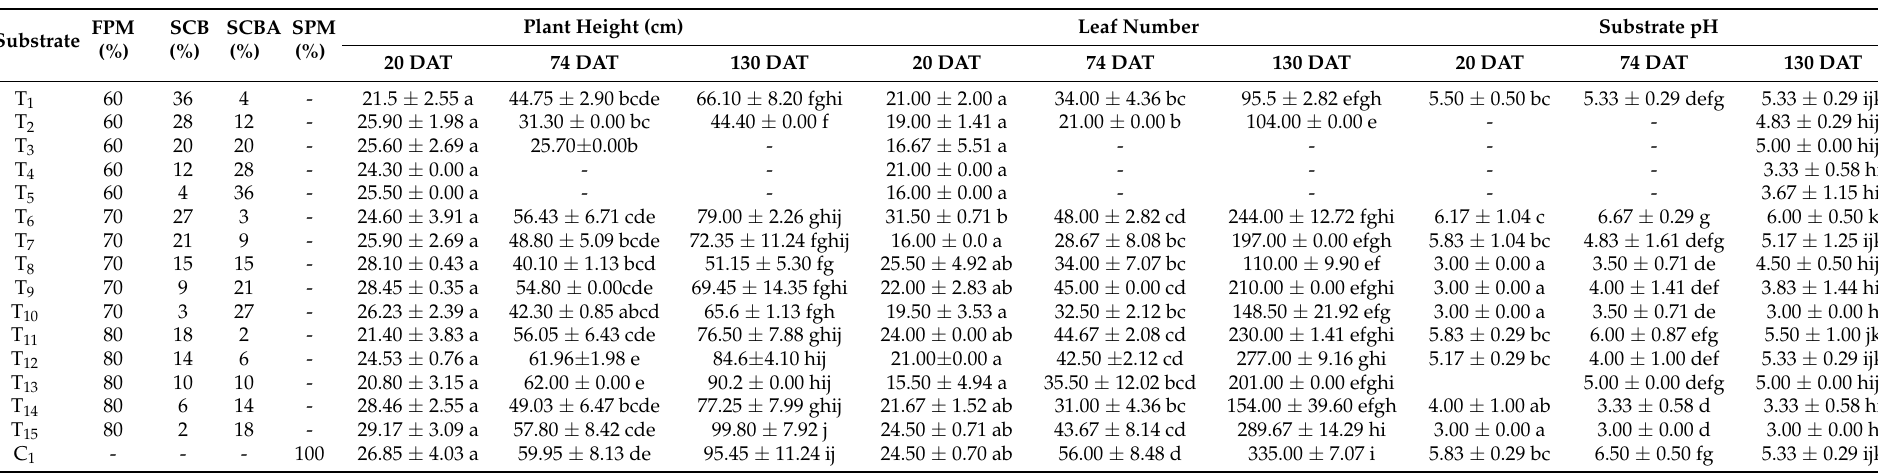
Table 3. Compositions of the proposed substrates and effect of the substrate composition on the plant height, number of leaves and substrate pH, after 20, 74, and 130 days after transplanting (DAT). Different letters after means indicate significant differences at p ≤ 0.05 (Tukey’s HSD